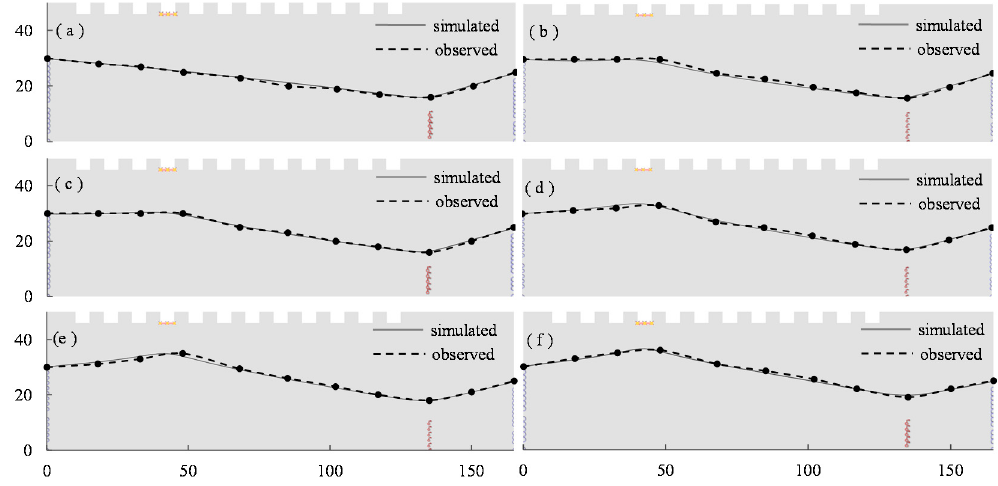
Figure 10. Comparison between observed and simulated groundwater levels at time of: ( a ) 0 min; ( b )